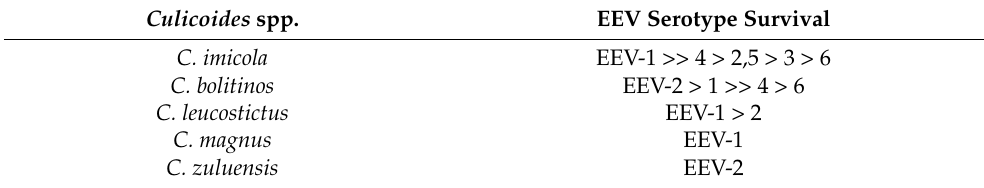
Table 2. Survival of EEV serotypes in various Culicoides species following 10 days incubation at 23.5 ◦ C after membrane feeding of infected blood